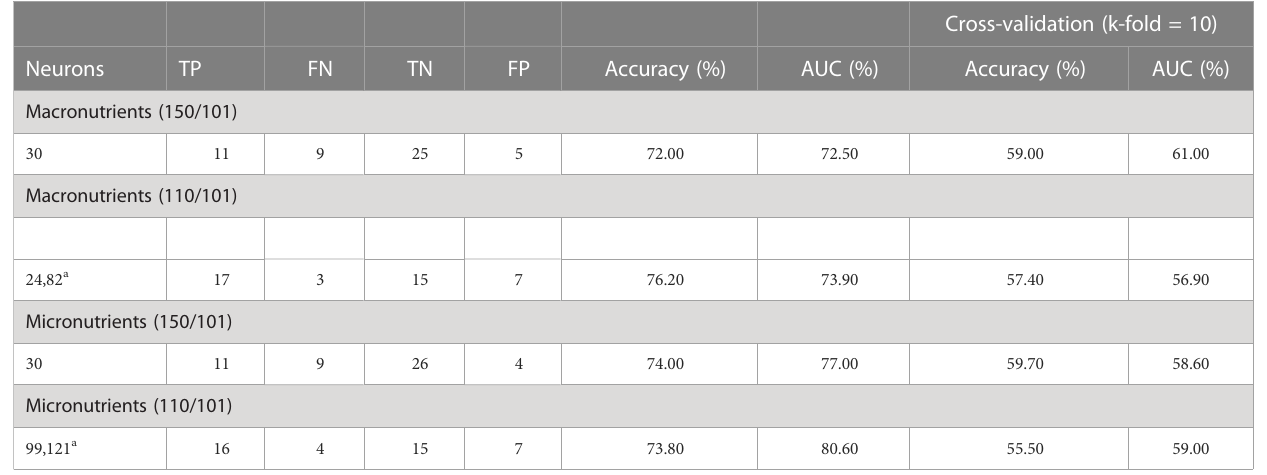
TABLE 5 Test results of the neural network structure optimized by genetic algorithm on balanced datasets.